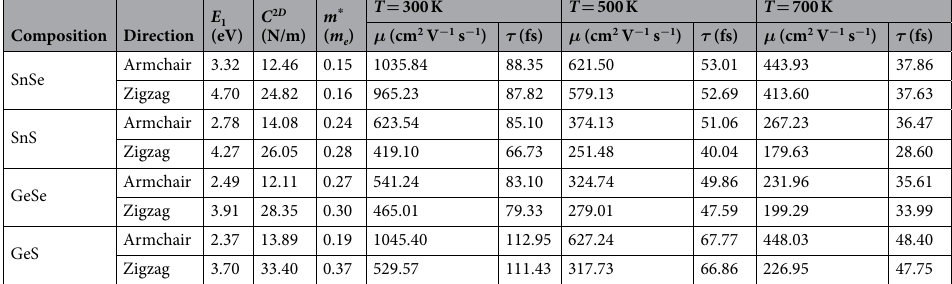
Table 2. Deformation potential constant ( E 1 ), two dimensional elastic constant ( C 2 D ), effective mass ( m * ), carrier mobility ( μ ) and relaxation time ( τ ) at 300 K, 500 K, and 700 K, in the armchair and zigzag directions of the group IV–VI compounds.